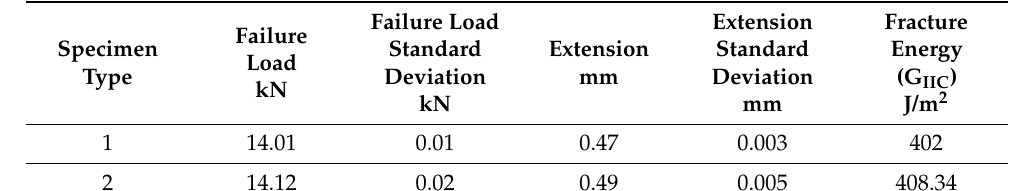
Figure 4. Comparison between match and mismatch lap joints: ( a ) load – displacement curve for ten- sile test; ( b ) failure loads along with error bars. Table 3. Summary of the tensile test results.